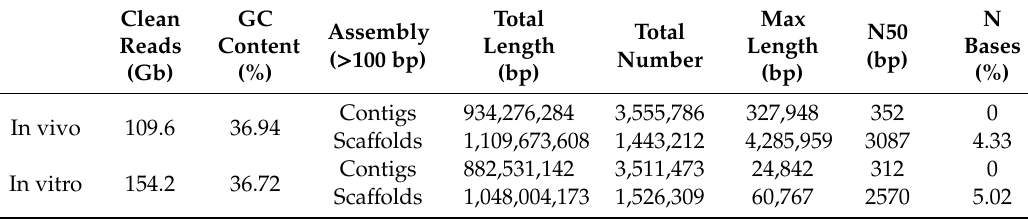
Table 4. Genome assembly statistics of M. cordata after